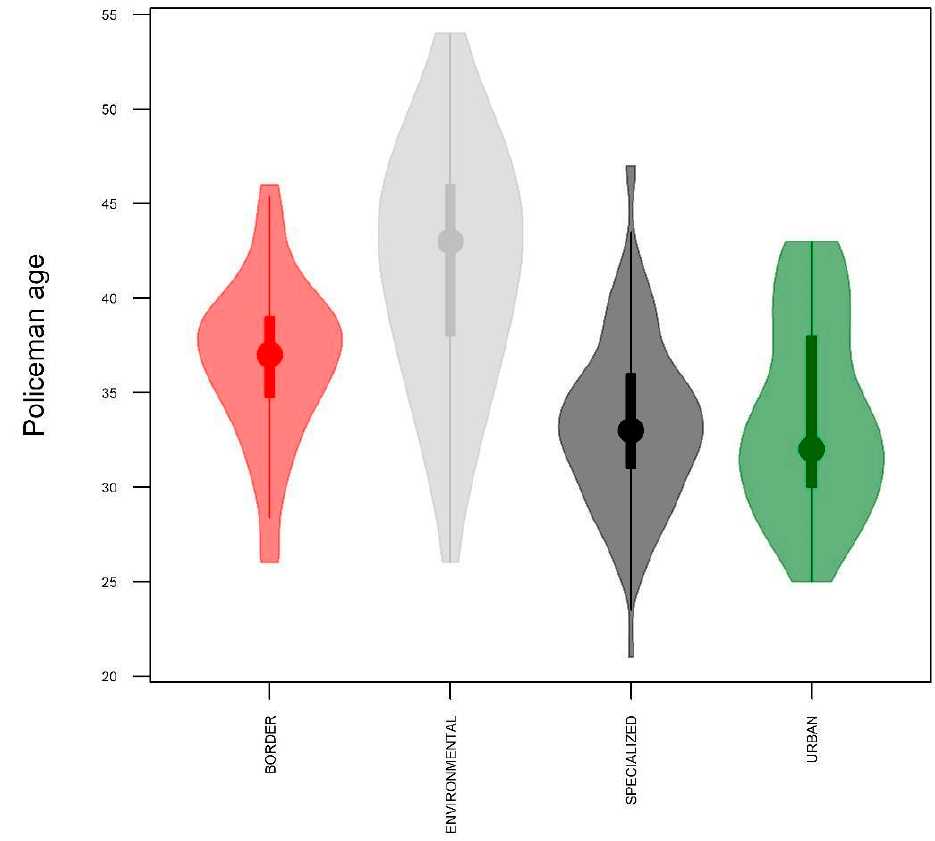
Figure 1. Age distribution of police officers according to specialties.